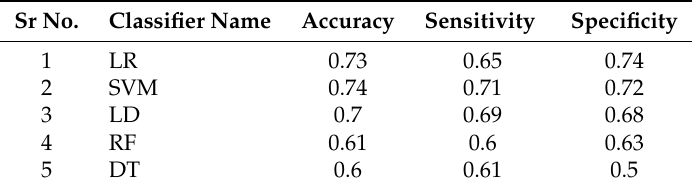
Table 7. 10-Fold Results based on the Top 1000 Selected Features based on Proposed 3-Stage Approach. Sr